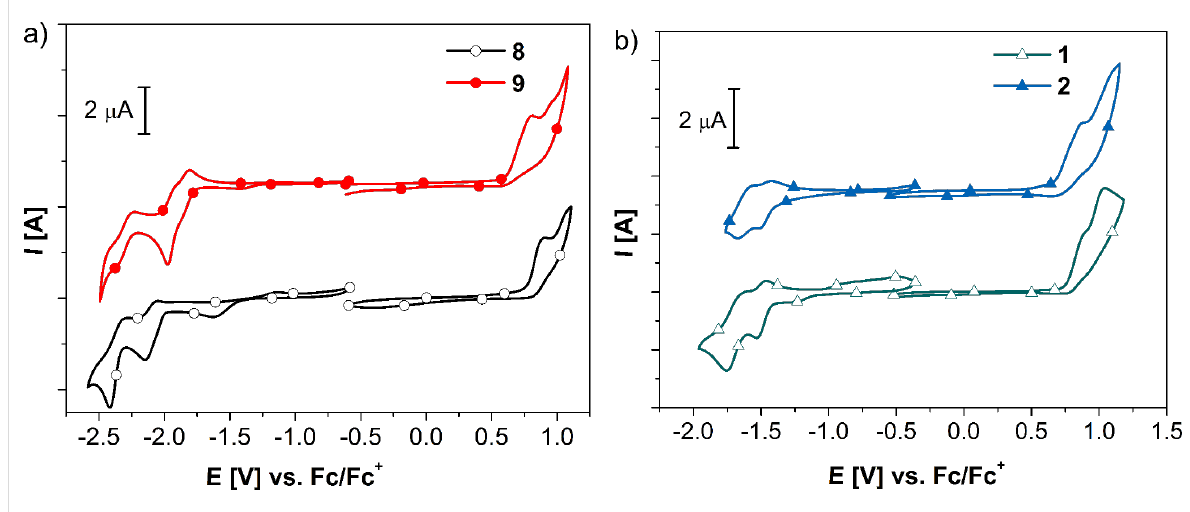
Figure 3: CV of 1.0 mM solutions of ligands (a) and complexes (b) in anhydrous dichloromethane (oxidation) and anhydrous DMF (reduction) by using TBAPF 6 (0.1 M) as a supporting electrolyte at 298 K under an argon atmosphere. Potentials are given against an internal Fc/Fc + reference. The scan rate was 100